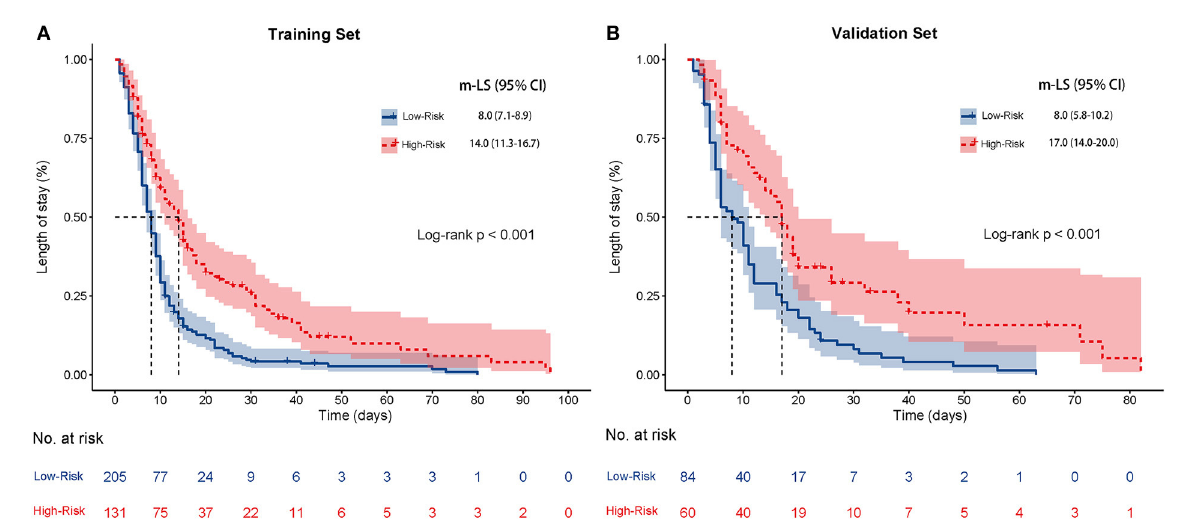
FIGURE6 Kaplan-Meier curves for the length of stay of high-risk patients and low-risk patients based on the optimal segmentation threshold obtained from the ROC analysis in the training set (A) and the validation set (B) . Abbreviations: m-LS: median length of stay.